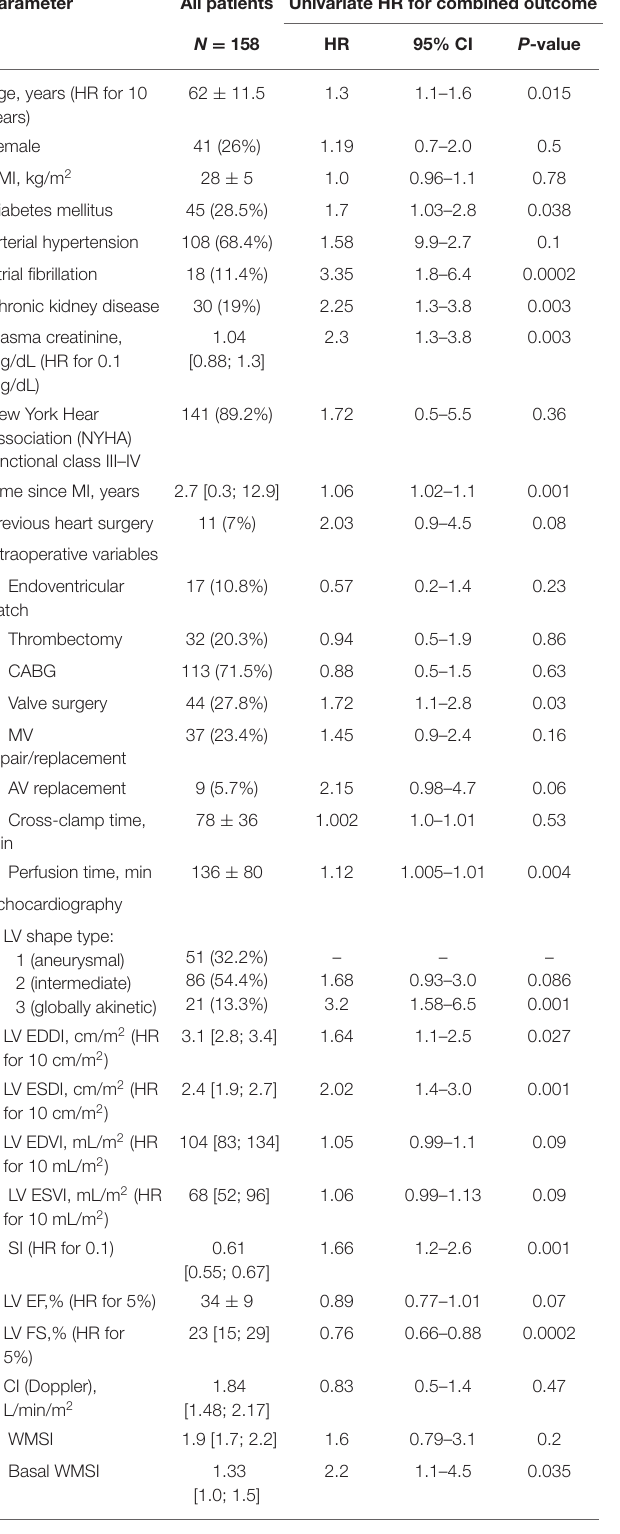
TABLE 1 | Patient baseline characteristics and the univariate analysis for predicting the combined outcome. Parameter All patients Univariate HR for combined